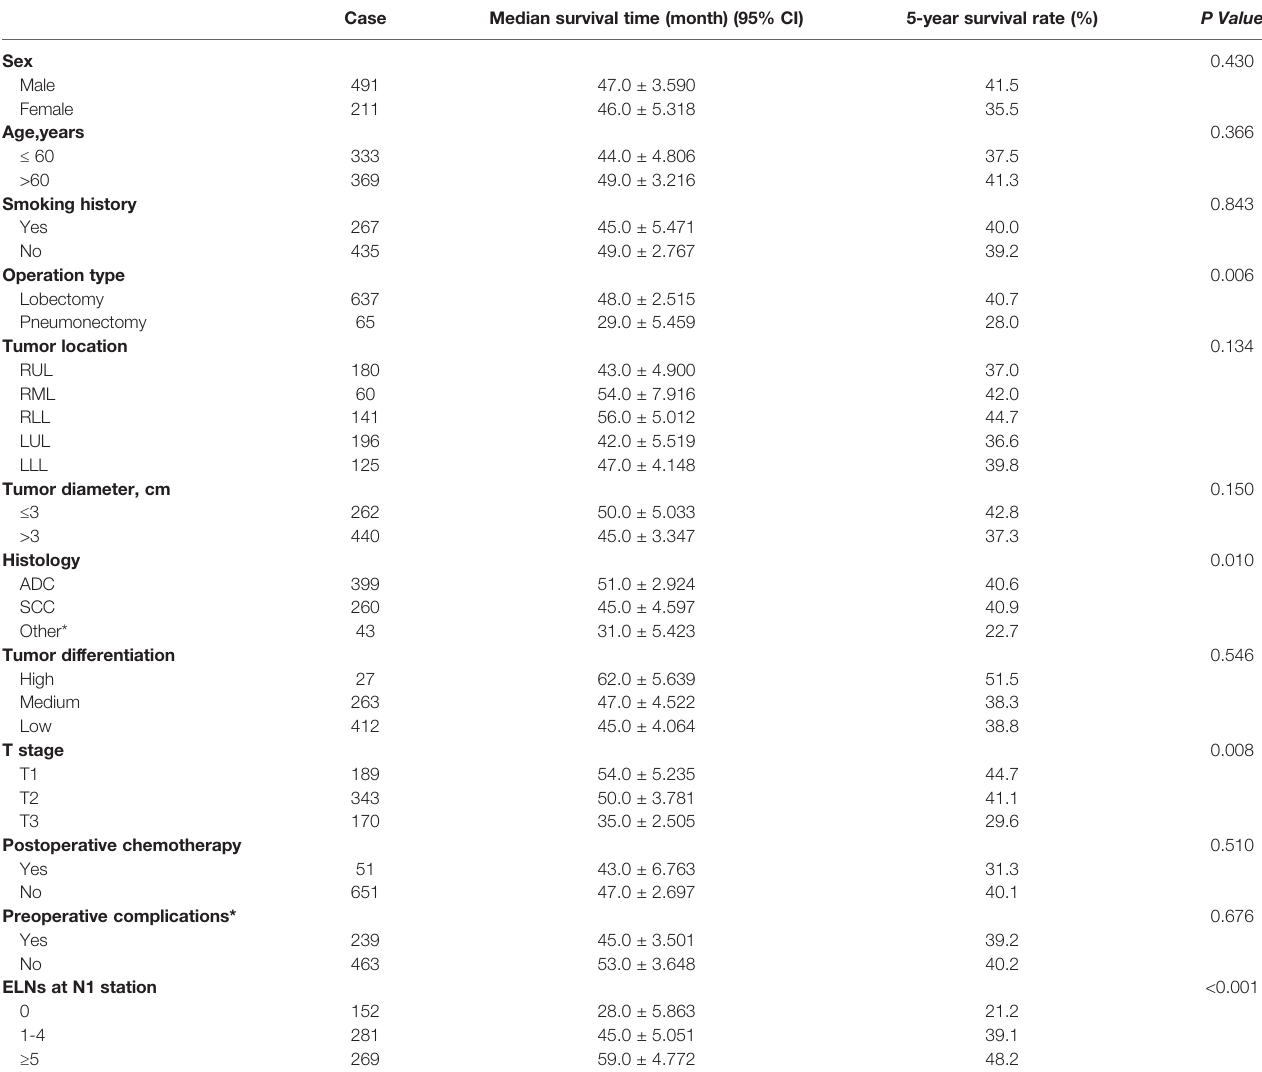
TABLE 2 | The prognostic factors associated with overall survival of patients in groups A, B, and C by univariate analysis.